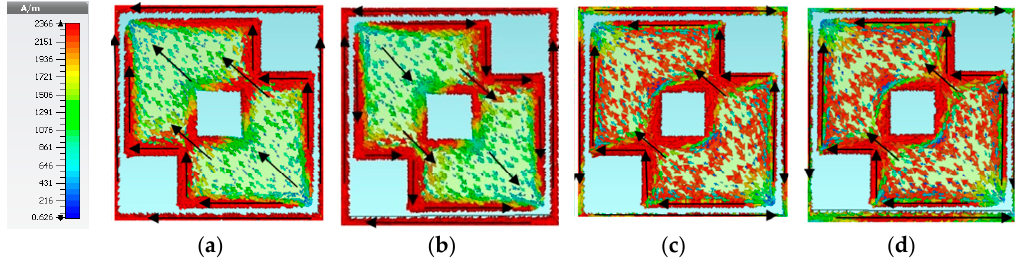
Figure 7. Surface current distributions at 1.085THz: ( a ) top surface; ( b ) ground surface; and at 1.454 THz: ( c ) top surface; ( d ) ground surface.